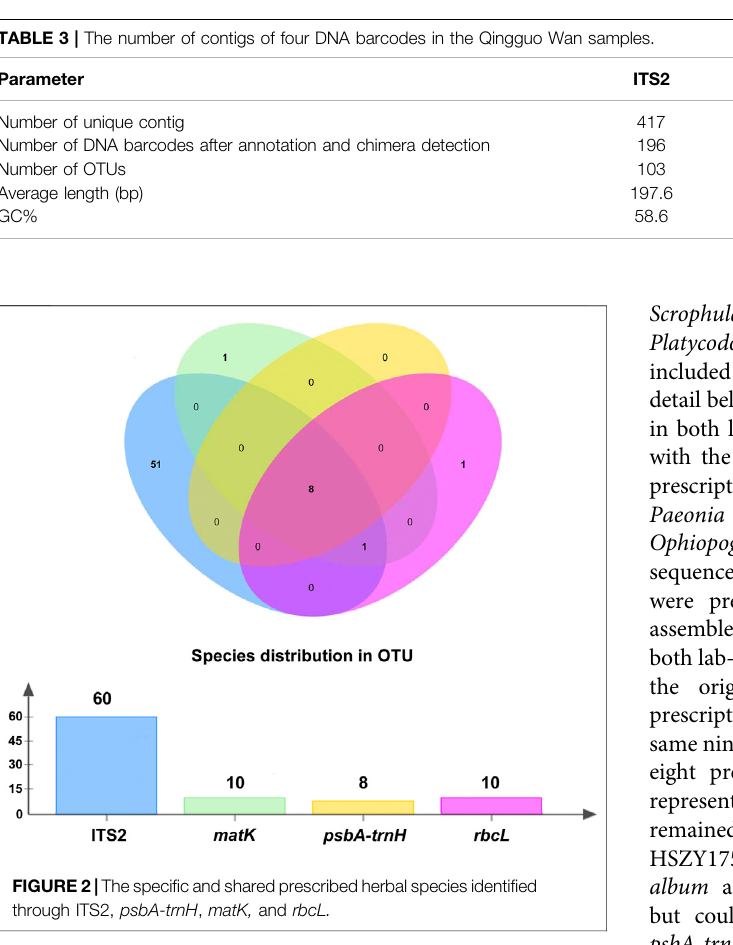
Frontiers in Pharmacology |